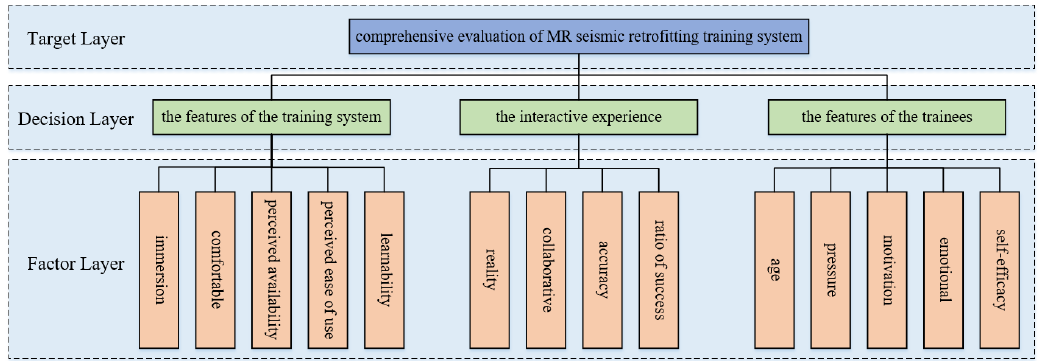
Figure 6. The AHP evaluation indicator system of the MR seismic retrofitting training system.